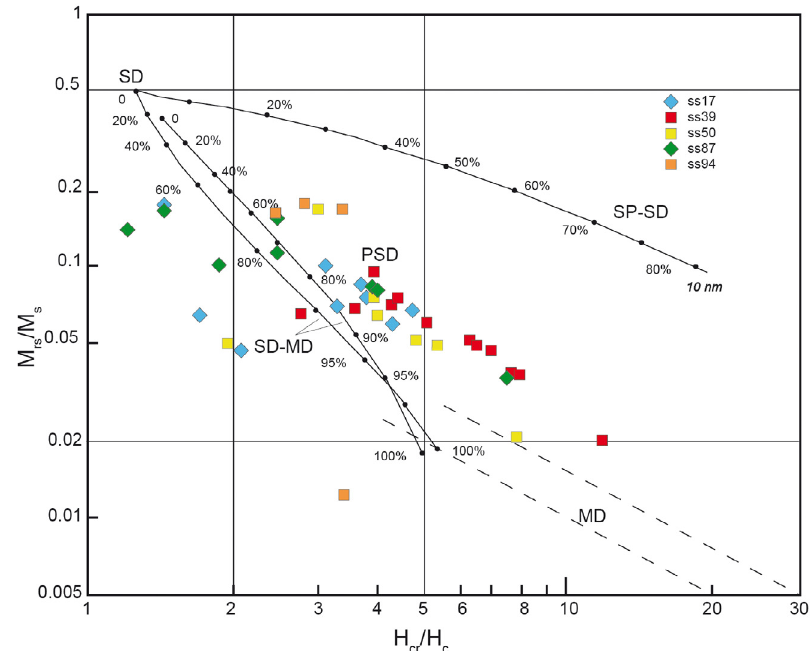
/M versus H /H Day plot for the discrete soil samples. Mixing theoretical curves for magnetite with the relative volume frac- Figure 5. M rs s cr c tion of the soft component (SP or MD) and boundaries of SD, PSD, and MD fields are reported (after Dunlop [2002]).